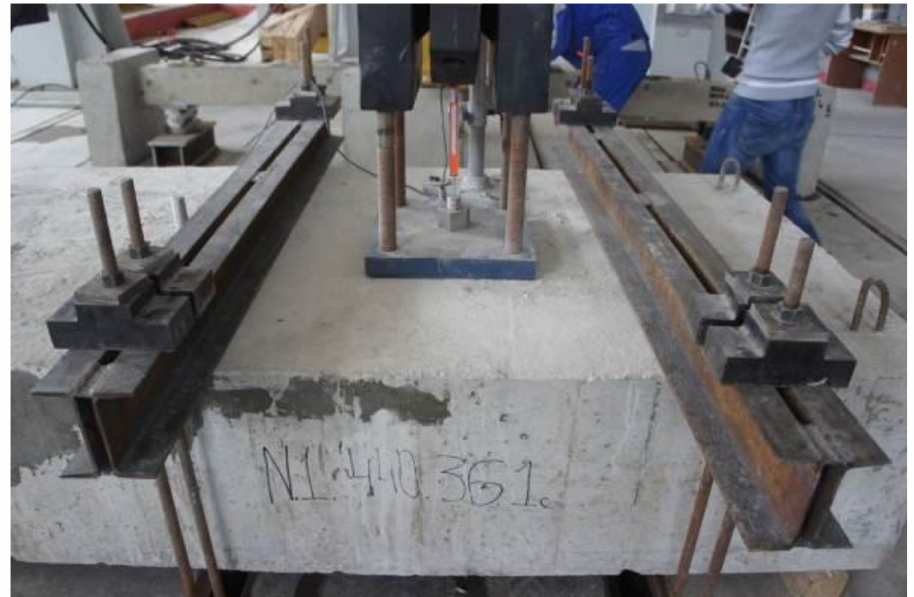
Figure 7. A setup for the axial load testing of anchors.